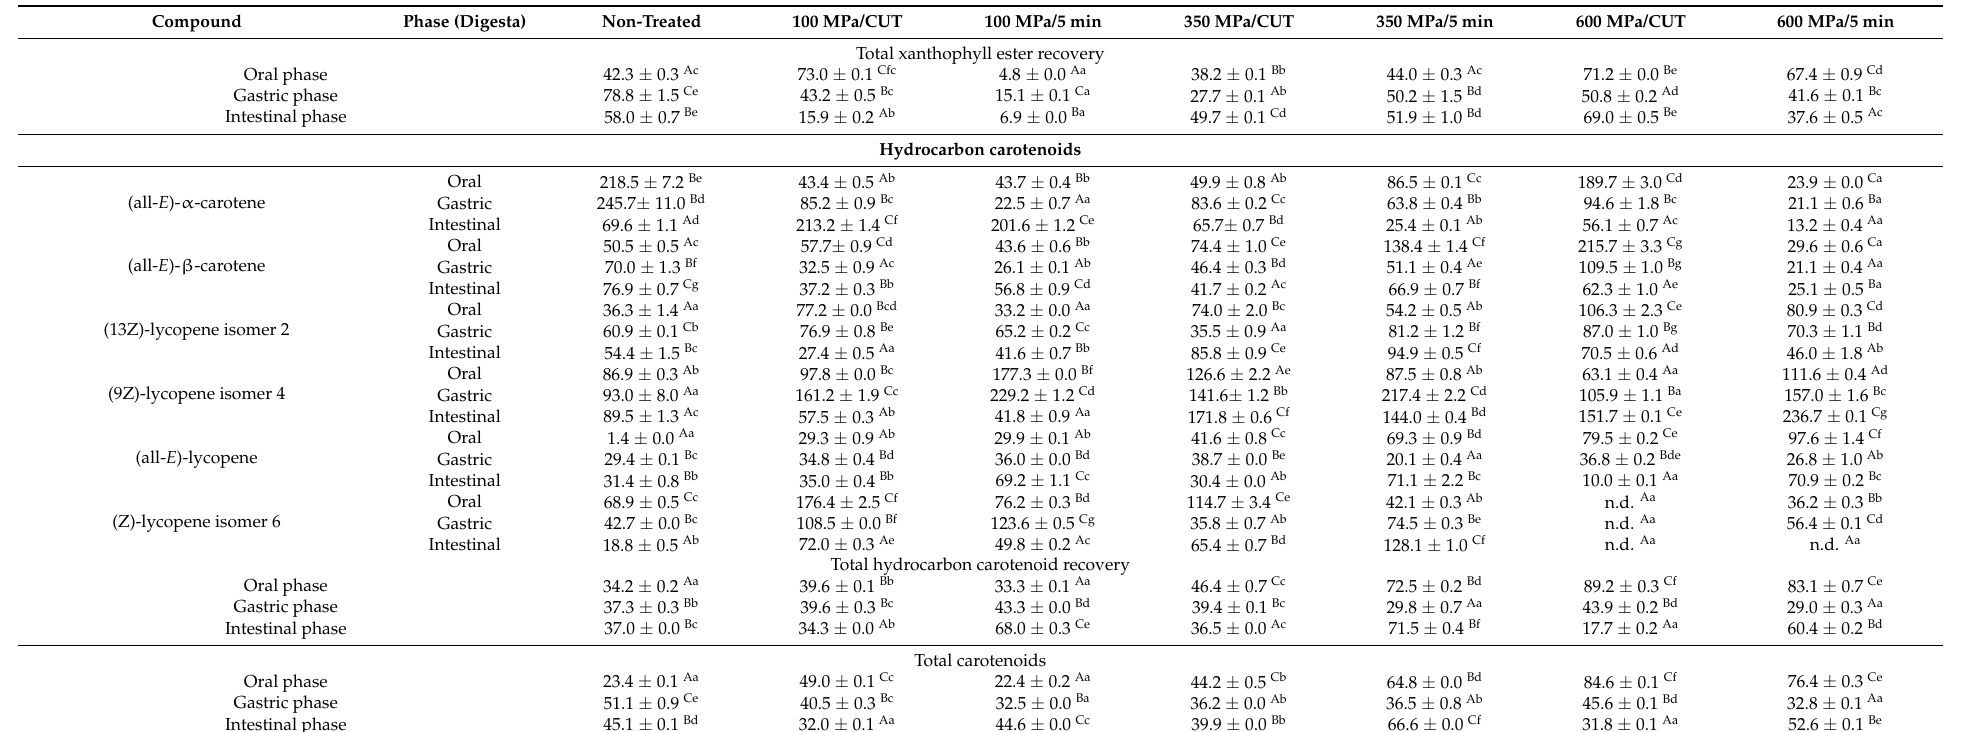
n.d., not detected. 1 Results are expressed as the mean ± standard deviation ( n = 4). This came from obtaining at least two independent digestions ( n = 2) and performing the determinations of each two times ( n = 2). Superscript capital letters indicate statistically significant differences of specific recovery of each compound evaluated ( p ≤ 0.05), between simulated in vitro digestion phases. Superscript small